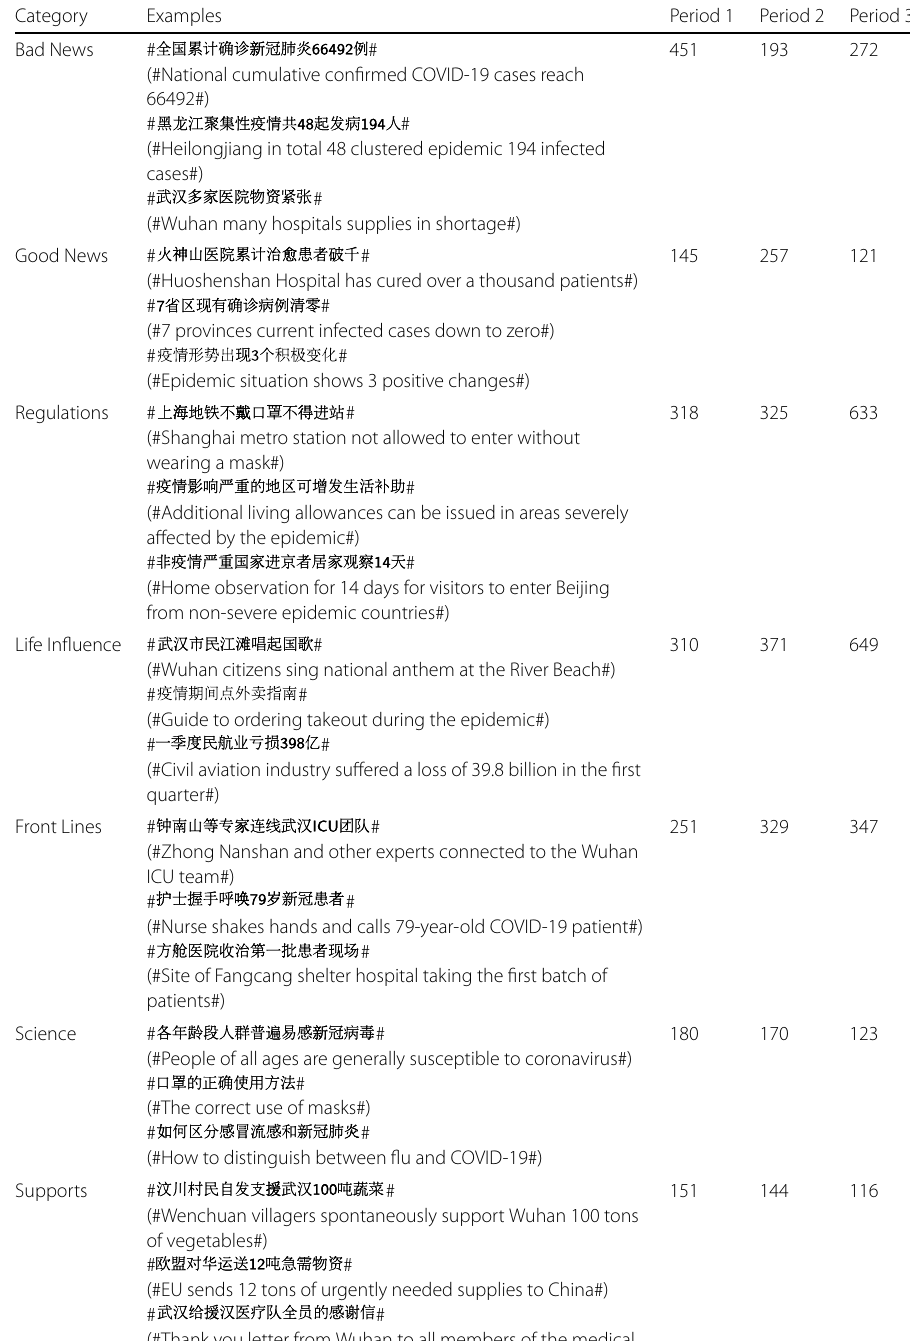
Table 1 Mainland China COVID-hashtag details. A summary of the example hashtags in each sub-category of Mainland China category and the number of hashtags in different time periods